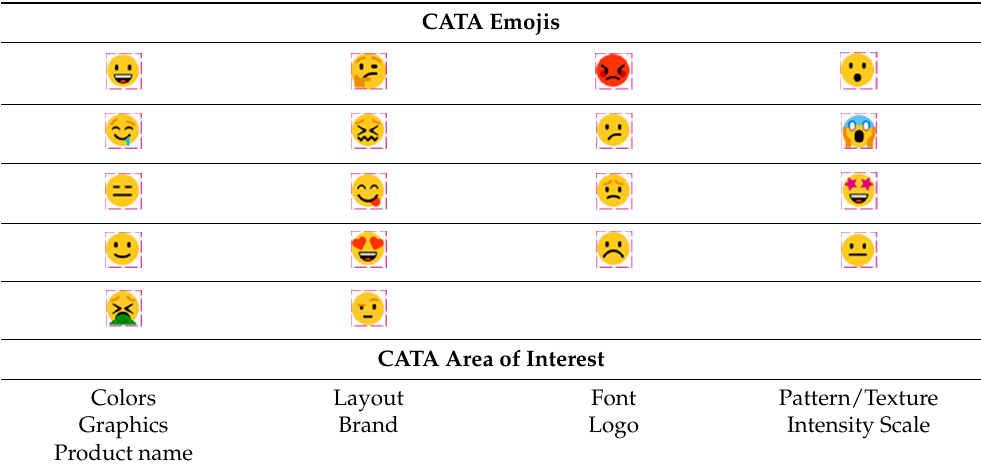
Table 2. Options provided for the check all that apply (CATA) questions for assessment of the coffee pod label samples.